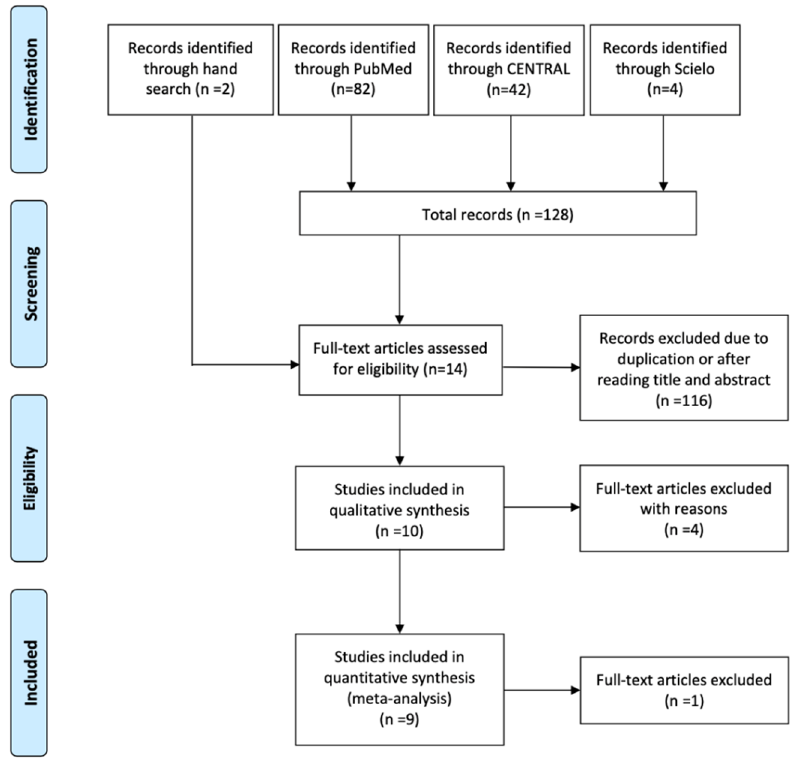
Figure 1. Preferred Reporting Items for Systematic Reviews and Meta-Analyses (PRISMA) flow diagram of selection process.